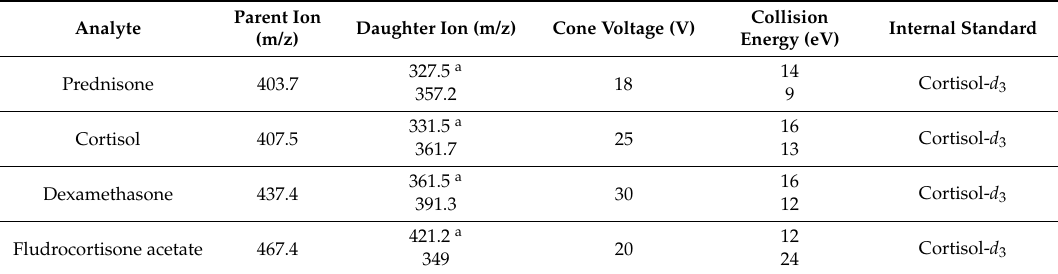
Table 1. High-performance liquid chromatography-tandem mass spectrometry (HPLC-MS/MS) conditions and internal standards for